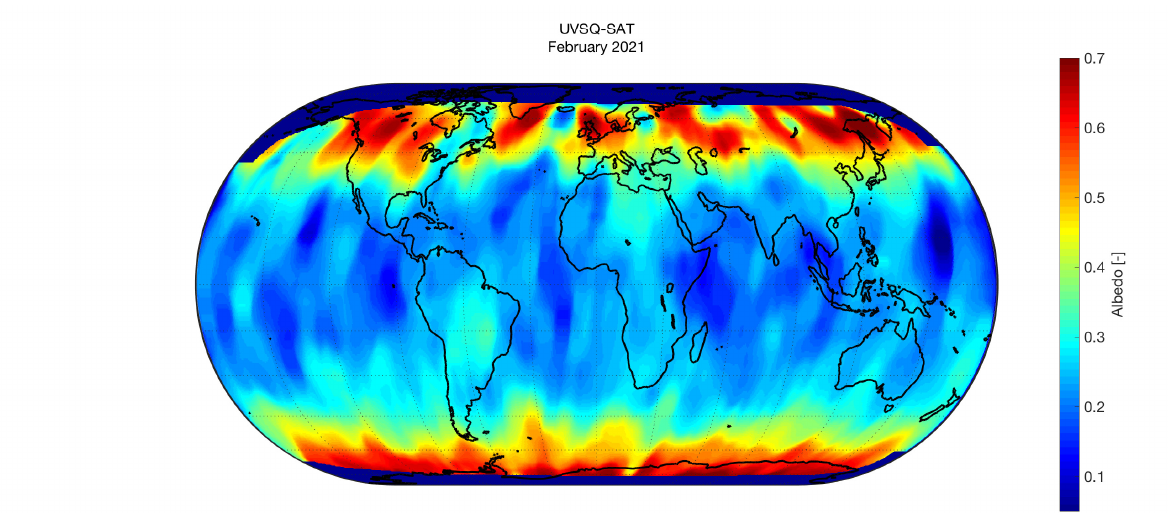
Figure 14. Earth’s albedo at TOA measured by UVSQ-SAT instruments. The dark blue areas correspond to regions without data.